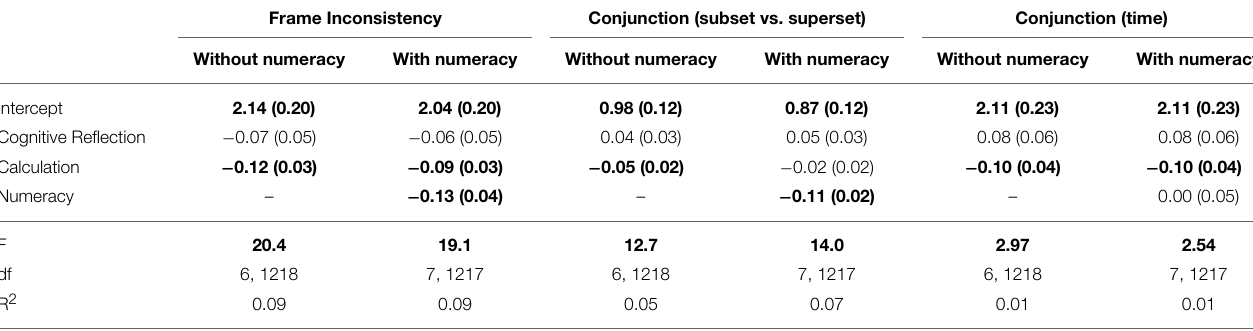
TABLE 5 | Regression analyses in Study 1—Consistency in risk perception and